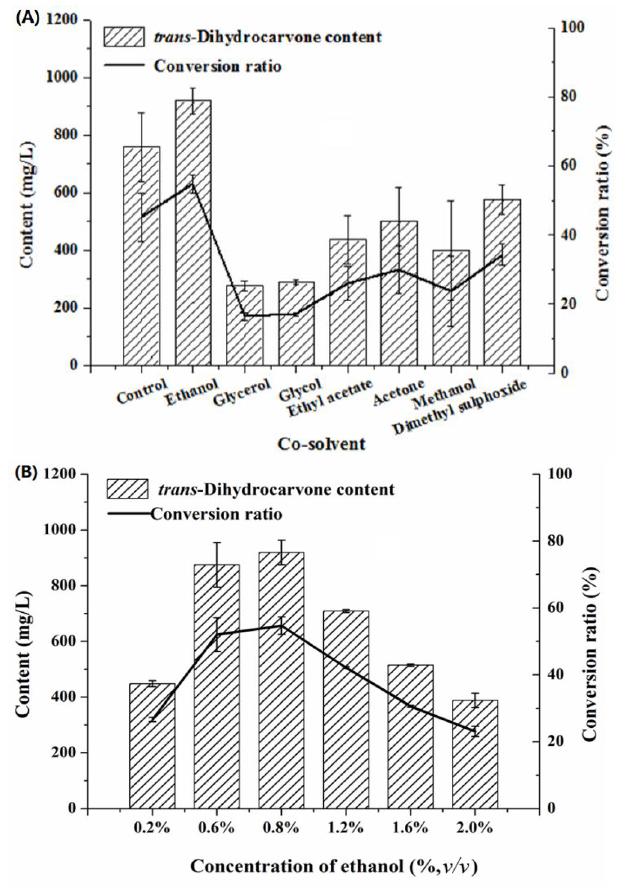
Figure 7. Effect of co-solvent on the production of trans -dihydrocarvone by Klebsiella sp. O852 (cultivation conditions were at 30 ◦ C and 150 rpm, limonene of 1680 mg/L was added as substrate) ( A ) Effect of different co-solvent on the production of trans -dihydrocarvone. ( B ) Effect of ethanol concentration on the production of trans